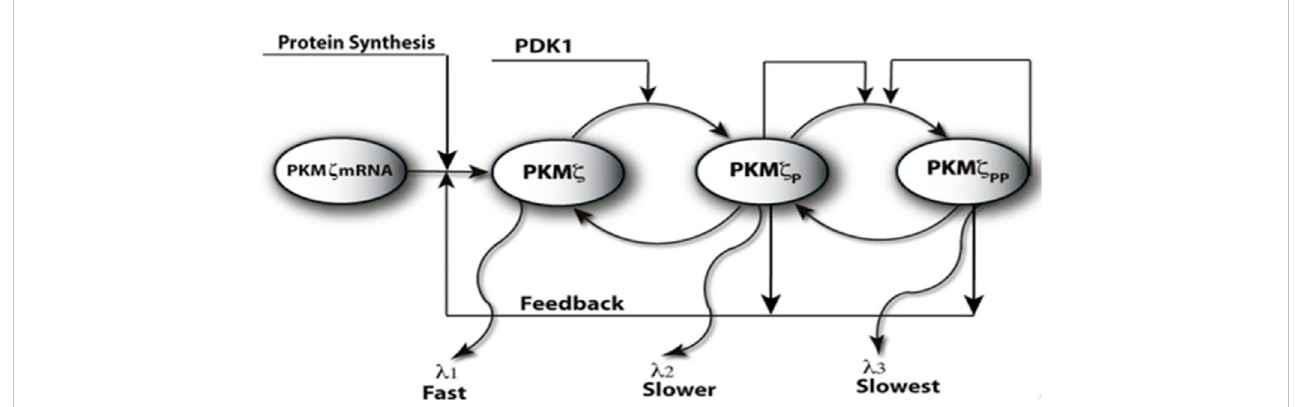
FIGURE 1 Proposed model of the local PKM ζ synthesis through PKM ζ translation/degradation and activation/deactivation molecular network. Here, the PKM ζ molecule isintheinactive or theactive andphosphorylated forms. ThePKM ζ issynthesizedinnaïve form fromitsmessenger RNAthrough aproteinsynthesis stimulation mediated by multiple second messenger-dependent kinases. The unphosphorylated kinase form is rapidly phosphorylated at site T410 through another constitutively active kinase, PDK1. The singly phosphorylated form of PKM ζ undergoes an autophosphorylation at site T560. The phosphorylation increases the stability of an otherwise unstable molecule. The PKM ζ molecule has different turnover times in all three states. The turnover time of the naïve molecule is the shortest, and it is the longest for the doubly phosphorylated form. The active form of the molecule also regulates the new synthesis of PKM ζ through a feedback loop.